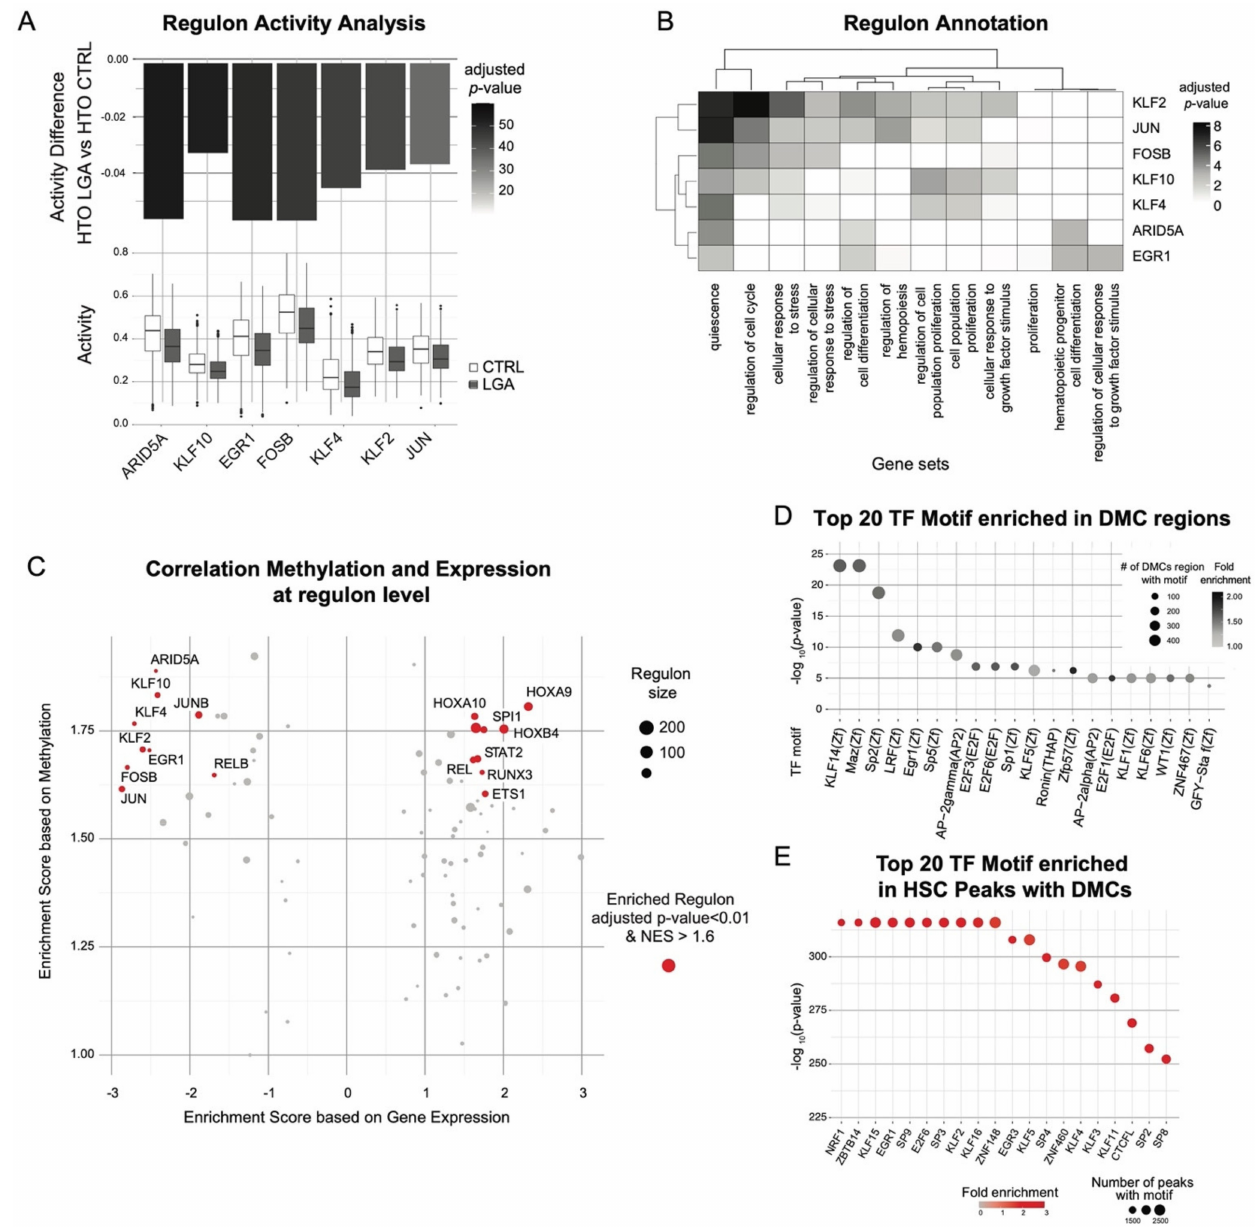
Figure 5. Epigenetic programming of HSC-specific regulons altered in LGA neonates. Regulons and TF target information were obtained through the SCENIC workflow. ( A ) Boxplots representing regulon activity score in CTRL and LGA HSC lineage. Barplot representing the change in regulon activity and significance comparing LGA vs. CTRL. Only significantly affected regulons are repre- sented (adjusted p -value < 0.001 and |activity score fold change| > 10%). ( B ) Heatmap representing association between altered regulons and selected gene sets annotation. ( C ) Volcano plot representing enrichment in the change in expression and DNA methylation in regulons. Regulons enriched con- sidering both expression and methylation (adjusted p -value < 0.01 and NES > 1.6) are in red. ( D ) Dot plot representing enrichment for TF binding motifs using HOMER considering a ± 20 bp region around DMCs. Dots are color-coded based on the significance of the enrichment and y-axis represent the number of regions with binding motif among DMCs. ( E ) Dot plot representing enrichment for TF binding motifs using HOMER considering peaks with DMCs. Dots are color-coded based on the fold-enrichment and y-axis represents the significance of the